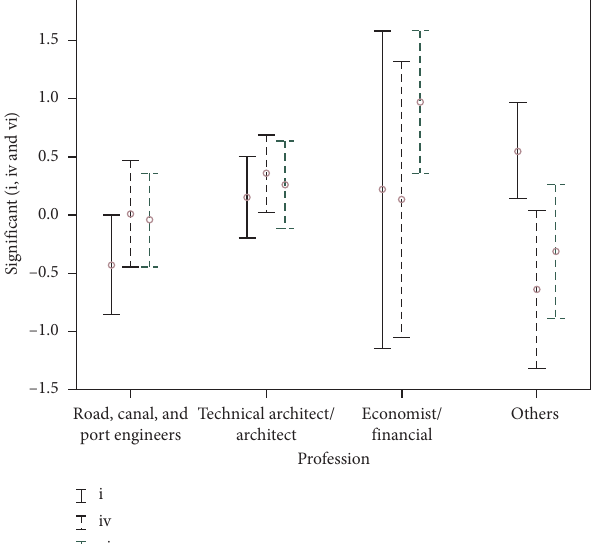
Figure 2: ANOVA internal drivers of innovation (i), technological links with the environment (iv), and innovation in processes (vi)/ profession, 95% least significance difference (LSD). ∗ Note: here, “others” means the following job titles: technician, industrial engineer, environmental engineer, or accountant.